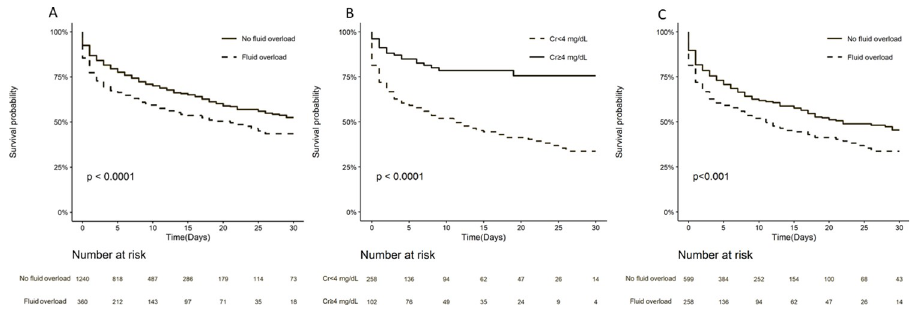
Fig 4. Kaplan–Meier survival curves for 30-day mortality in patients with or without fluid overload in the eICU dataset. A. The unadjusted 30-day mortality rate increased in the fluid-overloaded group. B. In patients with fluid overload, the low-creatinine (Cr < 4 mg/dL) group was associated with worse survival. C. In low-creatinine group, fluid-overloaded patients were associated with worse survival.